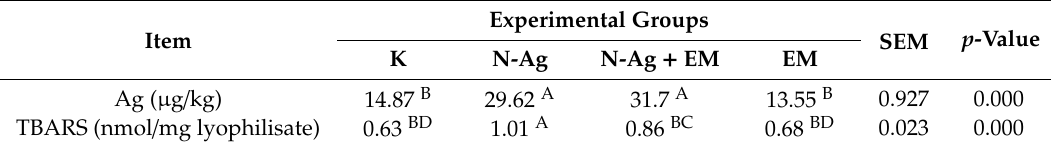
Table 6. Silver content and the level of the oxidative state index (thiobarbituric acid reactive substances (TBARS)) in the carcasses of Cornu aspersum (Müller) snails in the control and experimental